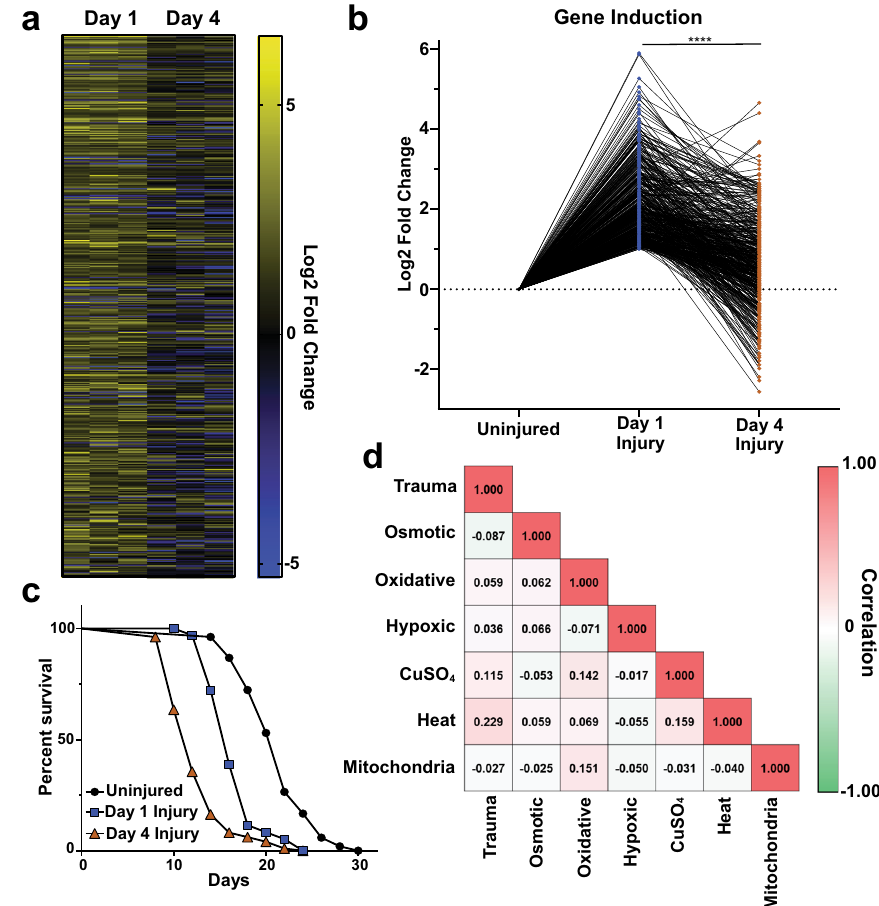
Fig. 2 Mechanical stress activates a distinct age-dependent transcriptional response. a Genome-wide transcriptional analysis of worms subjected to trauma at Day 1 or 4 of adulthood. Log 2 fold-change reported versus age-matched controls. Heat map displays 502 genes signi fi cantly regulated one hour after trauma in Day 1 adult worms (fold-change >2, p < 0.05, multiple two-sided t -tests), n = 3 biological replicates. Scale, yellow and blue intensity correspond to log 2 fold change in transcriptional activation and repression, respectively. b Log 2 fold-change trend of stress-activated transcripts at Day 1 (blue) and Day 4 (brown) of adulthood. Each gene was normalized to age-matched controls (Uninjured). **** p < 0.0001, two-sided t -test. c Worm lifespan comparing no injury (black circles) to moderate, paralytic injury at Day 1 (blue squares) or Day 4 (brown triangles) of adulthood. See Supplementary Table 1. d Cross-correlation matrix comparing induction of genes by mechanical stress to induction of those genes by other published stressors in C. elegans . The correlation coef fi cient for each condition is denoted in the corresponding box. Scale, red and green intensity correspond to positive and negative correlation,